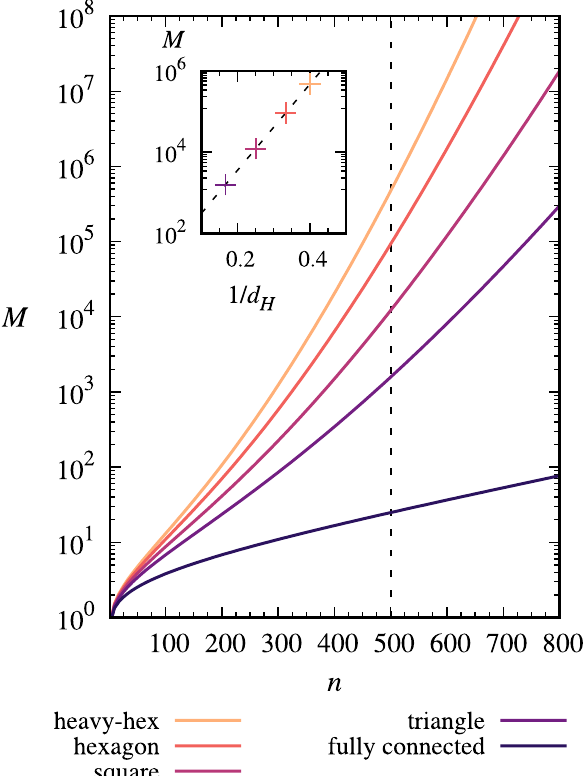
Figure 4. The number of measurement samples M to measure a result from the intended state for 3-regular graphs, see text for details. Inset: M diverges exponentially in 1 / d H